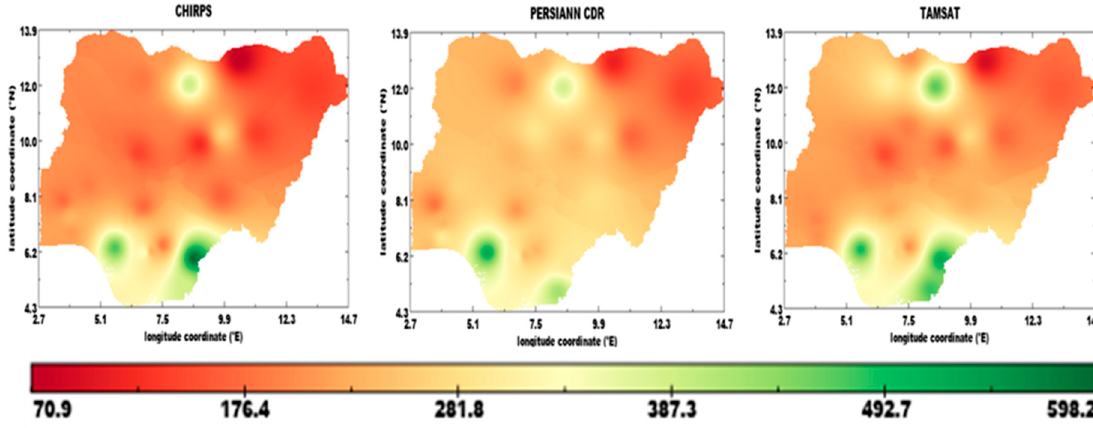
Figure 11. Root mean square error (RMSE) of annual rainfall (mm / year) over Nigeria.